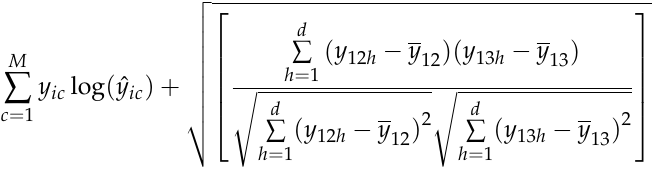
Figure 3. Single-layer fusion network, where x 1 represents the image features, x 2 represents the X rev Figure 3. Single ‐ layer fusion network, where 1 x represents the image features, 2 x represents the commodity comments, and x 3 represents the X pro commodity X commodity comments, and x represents the X commodity attributes. rev 3 pro